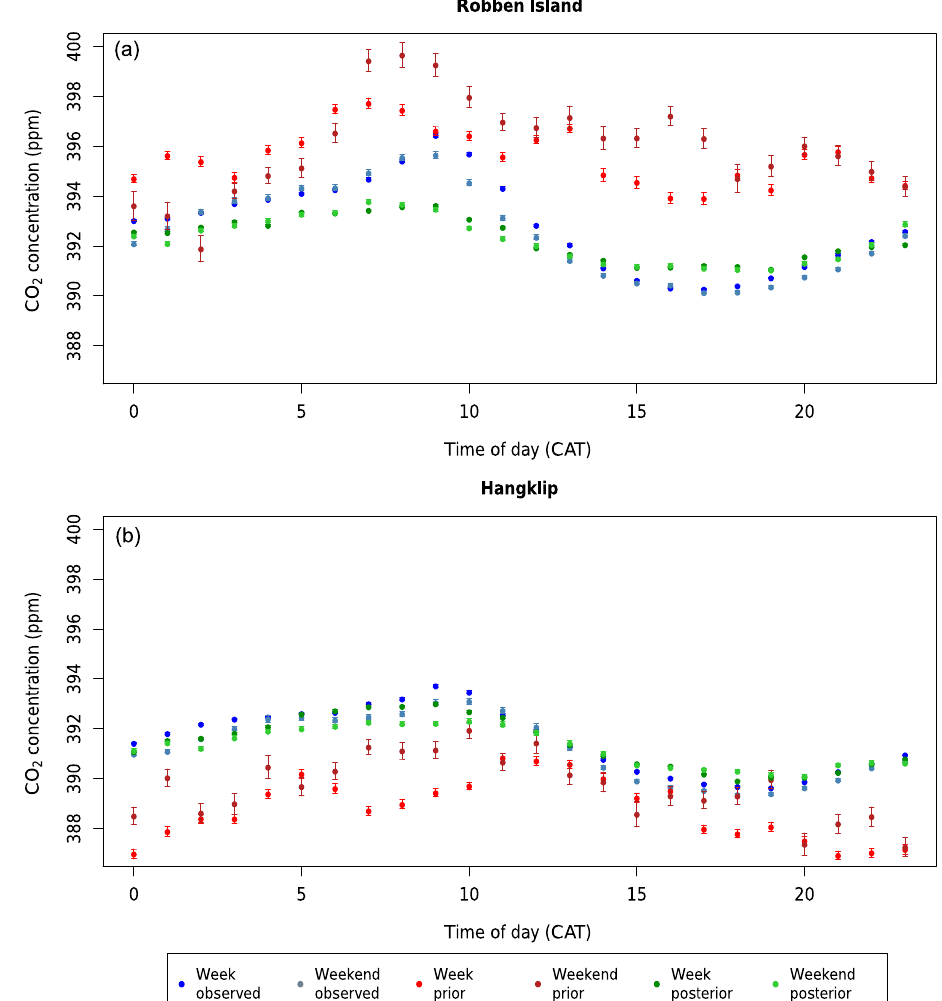
Figure 8. The hourly diurnal cycle (mean concentrations for each hour with 95% confidence interval) in the observed, prior, and posterior modelled CO 2 concentrations (ppm) over the full measurement period from March 2012 until June 2013, separated by working week and weekend and plotted separately for Robben Island (a) and Hangklip (b) measurement sites. The diurnal plots are separated into working week and weekend observed concentrations (blue and light blue), working week and weekend prior modelled concentrations (red and dark red), and working week and weekend posterior modelled concentrations (green and light